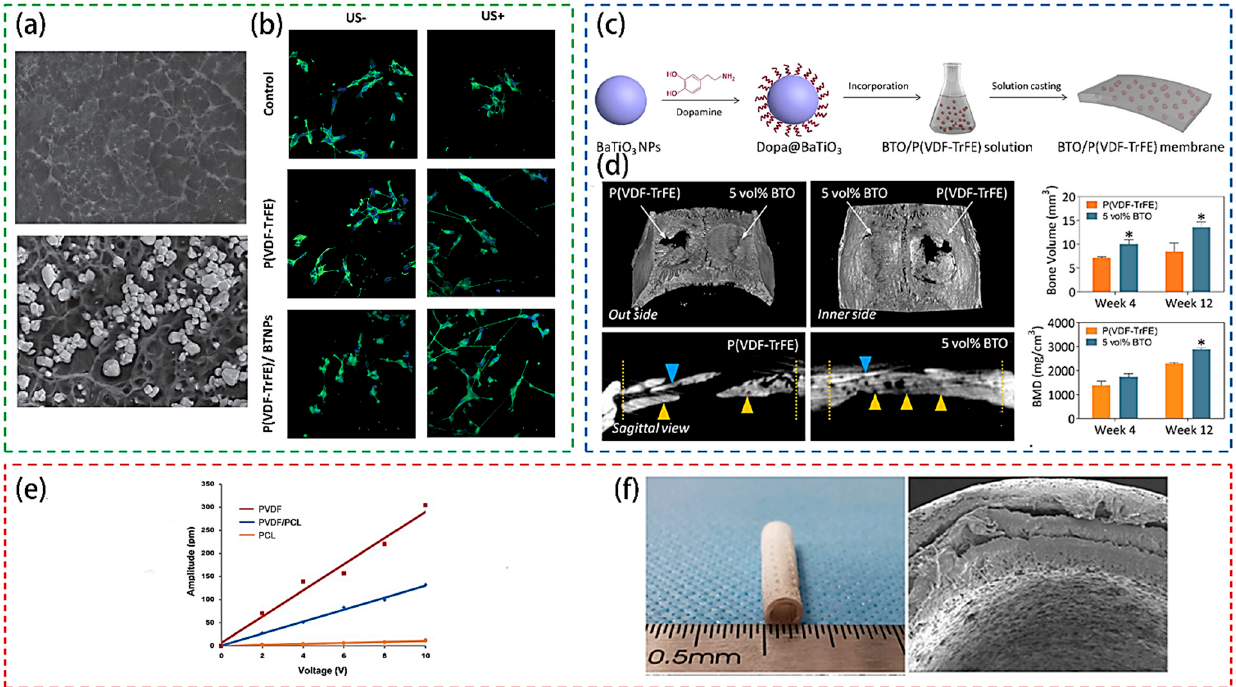
Figure 6. ( a ) Scanning electron microscopy images of P(VDF-TrFE) films and P(VDF-TrFE)/BTNP films. ( b ) Confocal fluorescence microscopy images of SH-SY5Y neuroblastoma cells at the end of a differentiation period of 6 days on P(VDF- TrFE), P(VDF-TrFE)/BTNP films, and on Ibidi film as control. Cells were either unexposed or exposed to chronic US stimulation. Reproduced from [32] with permission from the John Wiley and Sons, copyright 2016. ( c ) Schematic illustration of the preparation process of BTO/P(VDF-TrFE) membrane. ( d ) Bone defect repair in rat calvarial models after implantation of polarized nanomembranes with 5 vol% BTO content and polarized neat P(VDF-TrFE) membranes. Reproduced from [140] with permission from the American Chemical Society, copyright 2016. ( e ) Piezoelectric response of PVDF, 20% PVDF/PCL, PCL, in terms of the average values of amplitude responded to applied a.c. voltage. ( f ) SEM images of the multilayered and microporous structure for 20% PVDF/PCL scaffolds. Reproduced from [30] with permission from the Elsevier, copyright